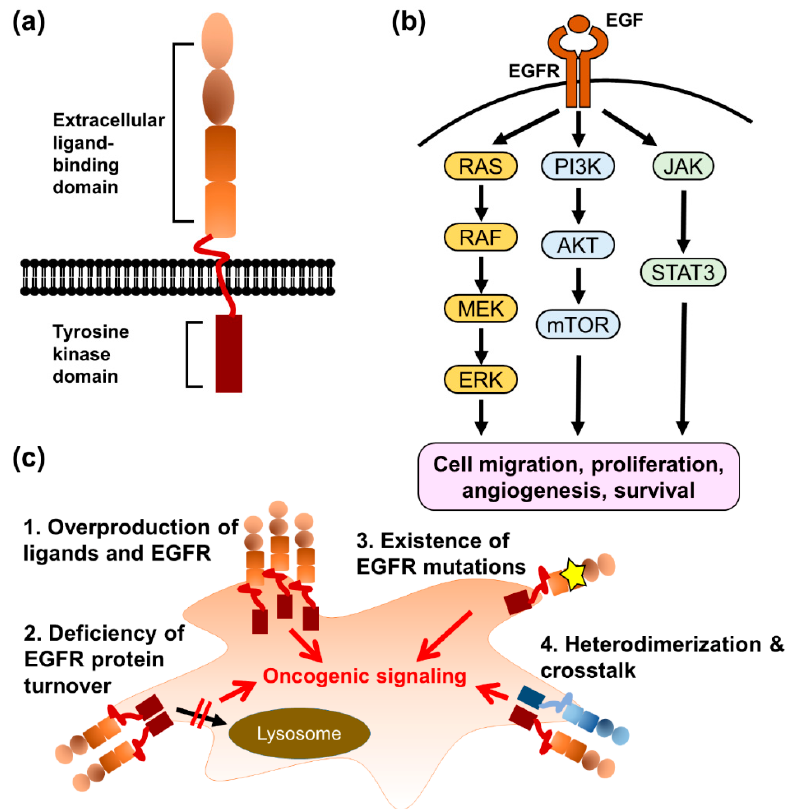
Figure 2. The mechanisms of acquired EGFR-TKI resistance. ( a ) The illustration of EGFR structure. ( b ) The downstream signaling pathways of EGFR contribute to cancer progression. ( c ) The EGFR gene amplification, deficiency of protein degradation, acquired T790M mutation, and different EGFR constitution are the major causes of EGFR-TKI resistance.